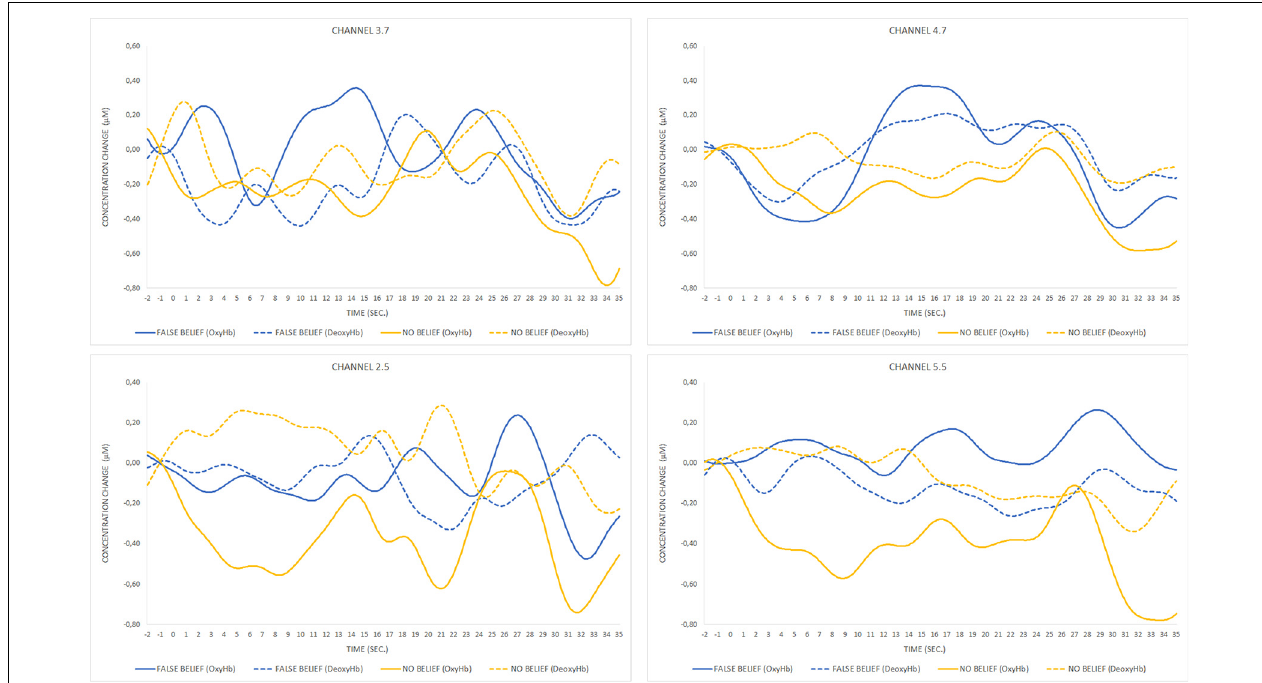
FIGURE 6 | Time course of oxygenated hemoglobin (OxyHb) and deoxygenated hemoglobin (DeoxyHb) concentration change for pairs of significant channels over FB and NB trials. The peak of OxyHb concentration in the FB condition for channels 3.7 and 4.7 located in the right temporal region corresponds to the timing of the toy’s location transfer (13–19 s) and is not observed during the same event occurring in the NB condition (17–23 s) or any condition within the pair of channels located in the left hemisphere.